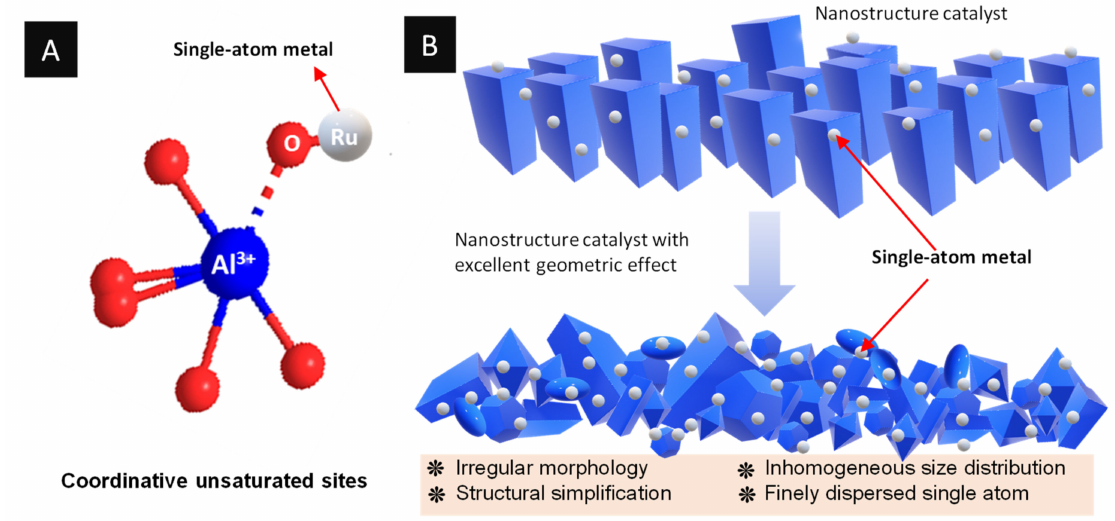
Figure 5. Illustrations of ( A ) SACs on unsaturated sites of Al 3+ support and ( B ) geometric effect on nanostructure